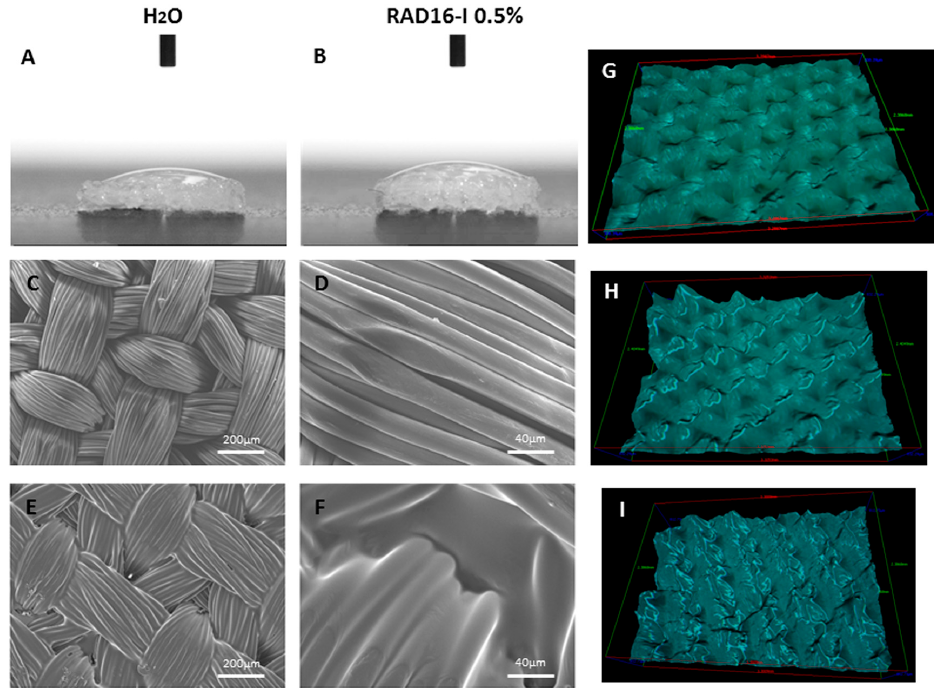
Figure 1. Wettability and fiber architecture of woven poly ( ε -caprolactone) (PCL) scaffold and PCL/RAD16-I self-assembling peptide composite scaffold. ( A ) Water contact angle; ( B ) RAD16-I 0.5% solution contact angle; ( C ) Surface view of PCL structure by scanning electron microscope (SEM); ( D ) Close up of panel C of microfiber detail; ( E ) Surface view of composite PCL/RAD by SEM. RAD16-I 0.5% was lyophilized within the PCL scaffold; ( F ) Close up of panel E; ( G ) Three-dimensional (3D) view of PCL scaffold surface; ( H ) 3D view of PCL scaffold surface wet with water; ( I ) 3D view of PCL/RAD composite scaffold surface.